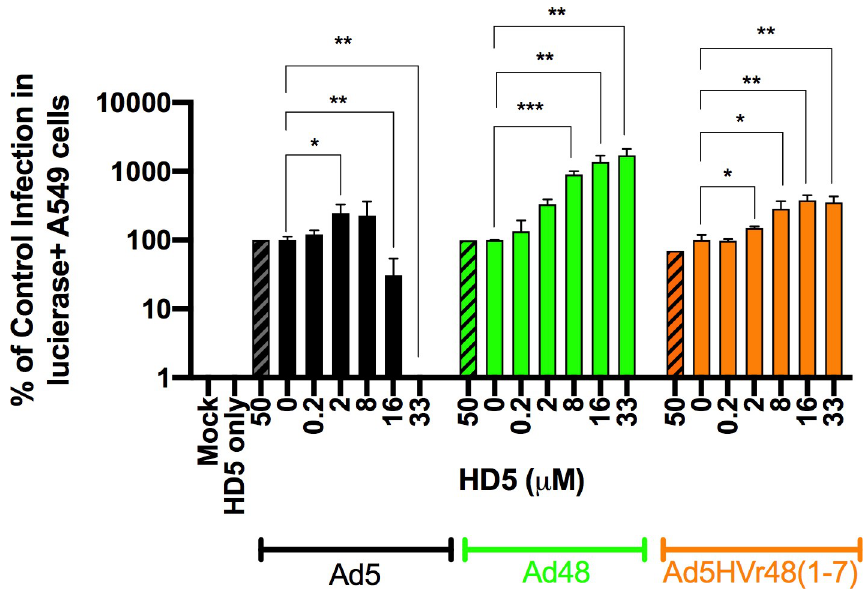
Fig 2. Analysis of Ad5HVR48 sensitivity to HD5 in A549 cells. Ad5, Ad48, and Ad5HVR48 were incubated with 0.2 μ M– 33 μ M HD5 or 50 μ M mutant HD5 (diagonal box) and assessed for % of cells expressing luciferase 24 h post infection. Experimental results are normalized to control infected with virus (100%) in the absence of peptide. Data is expressed as the mean ( ± SD) of three independent experiments. ��� p < 0.001, �� p < 0.01, � p < 0.05, one-way ANOVA test (compared to virus only